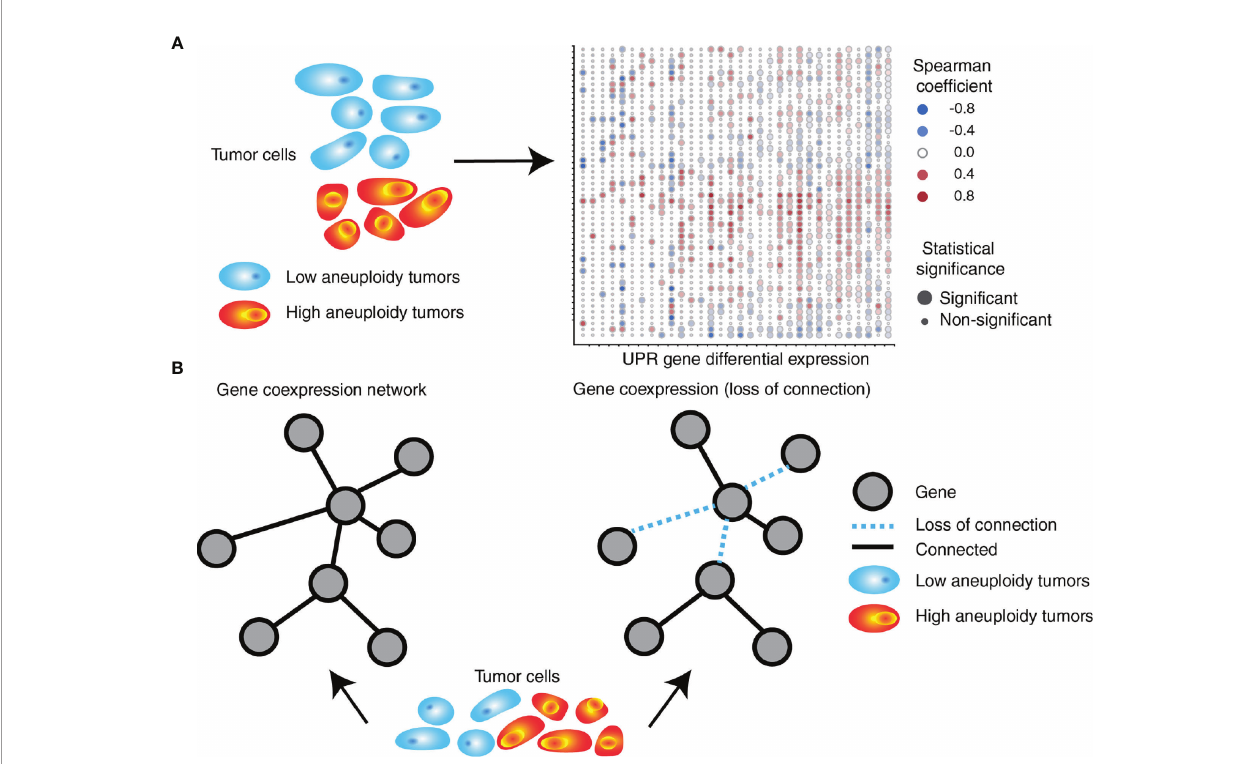
FIGURE 4 | SCNA level associates with perturbation of coordinated UPR gene expression. (A) UPR genes are differentially expressed in tumors with high levels of aneuploidy relative to those with low levels of aneuploidy. The right side depicts a heatmap exemplifying gene expression (in rows) differences between high and low aneuploid tumors across 32 different tumor types (in columns) from TCGA. (B) UPR gene coordination is altered in high aneuploid tumors relative to low aneuploid tumors. UPR genes in high aneuploid tumors are overall less co-expressed (loss of connection) compared to low aneuploid tumors, with some gene pairs showing unexpected levels of preservation across